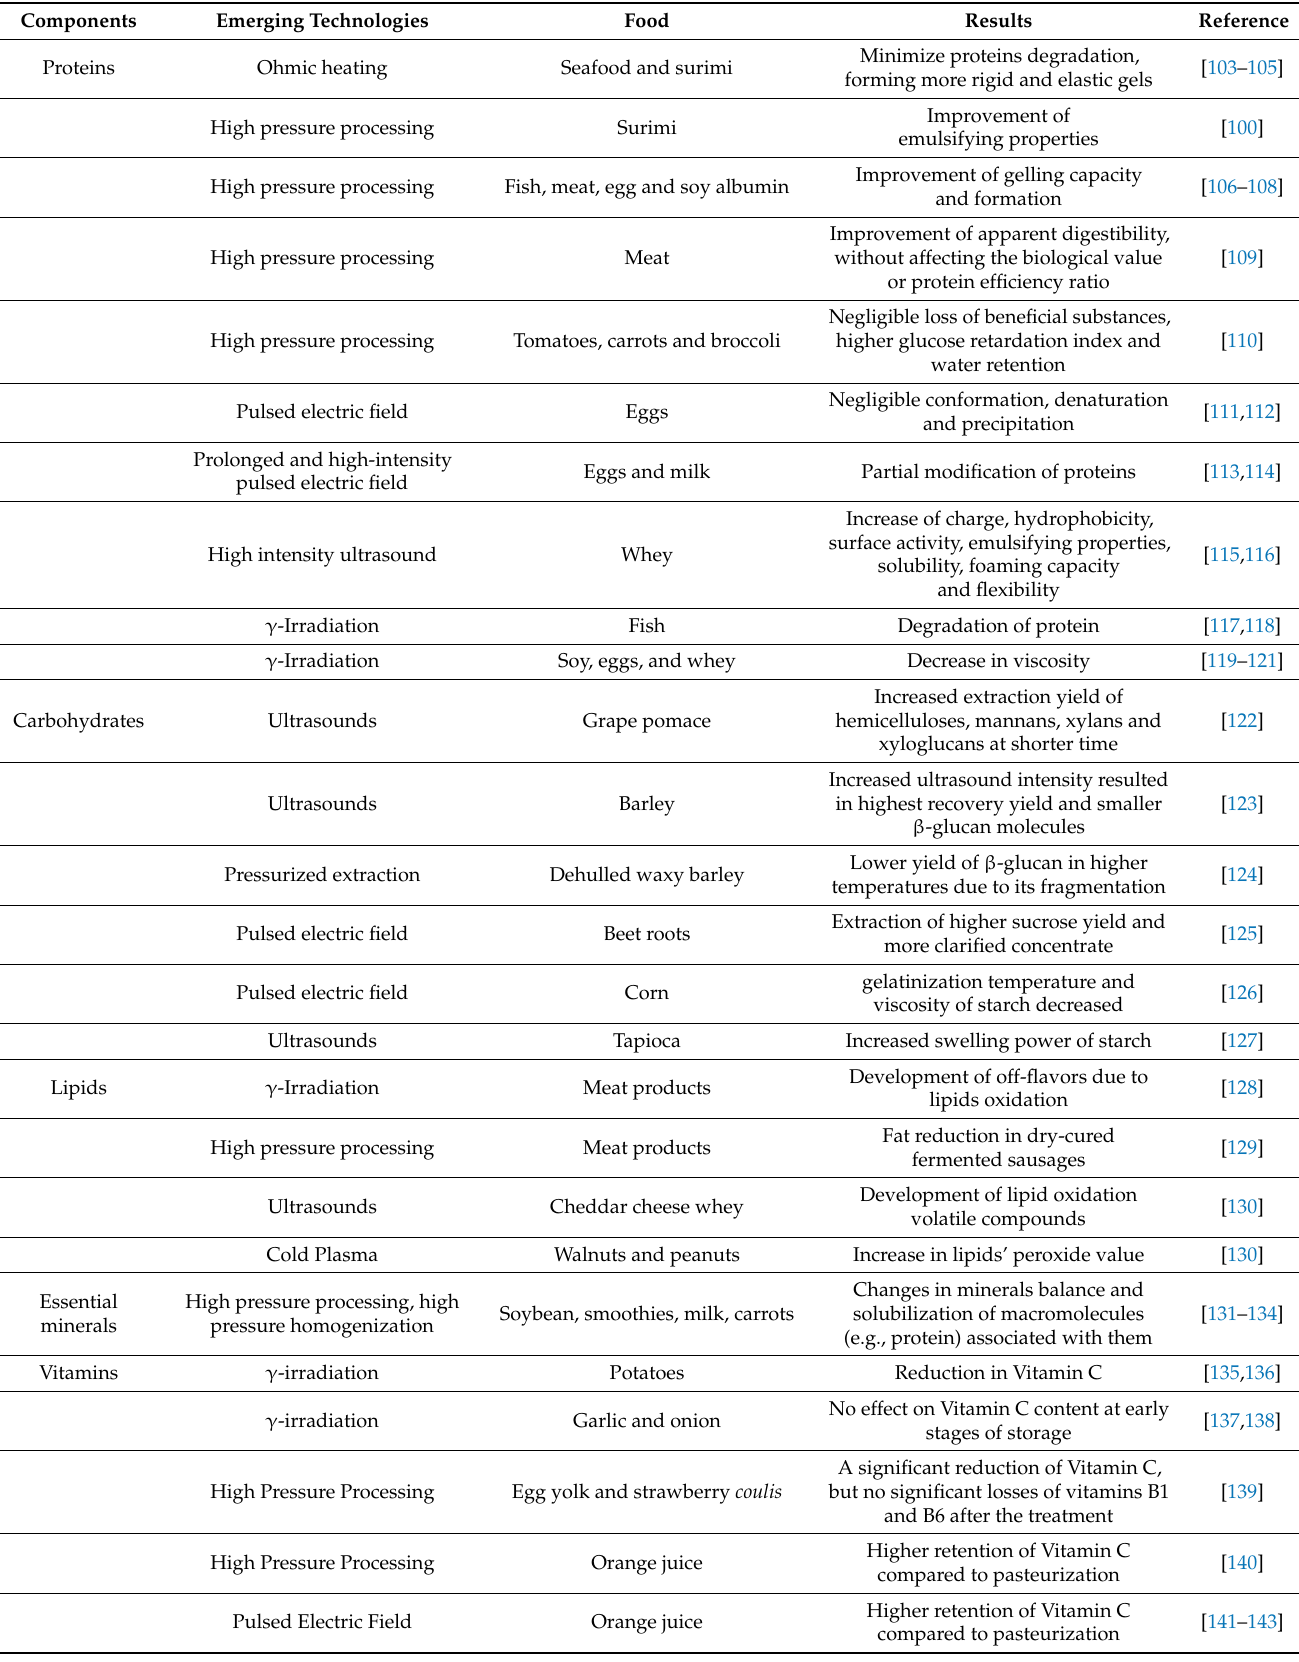
Table 1. The effects of emerging technologies on different food